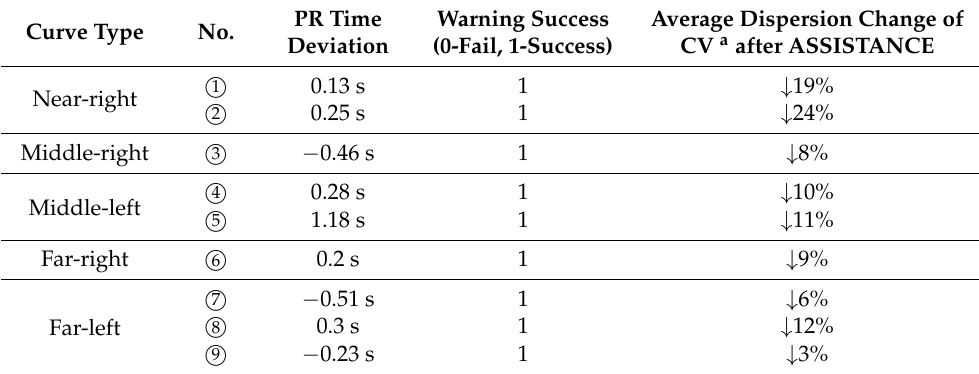
Table 7. Perception-Response Time Assistance Model